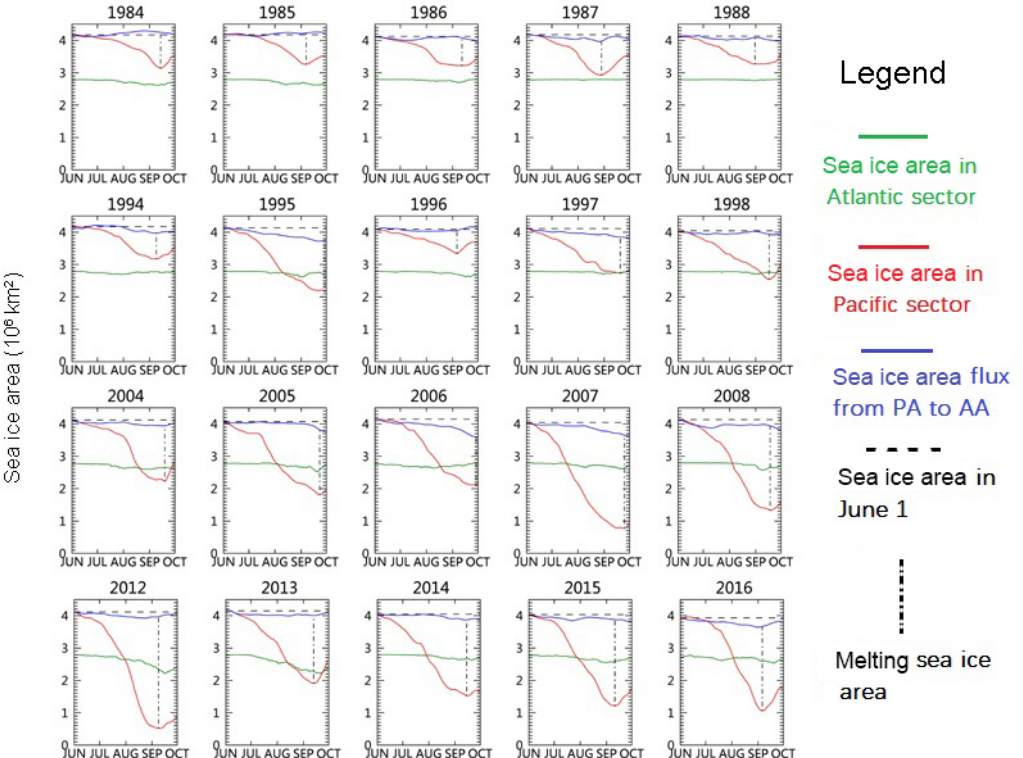
Figure 9. Selected daily changes in sea ice areas within the PA (red) and AA (green) during summer (June–September) for the period 1979– 2016. The horizontal dashed line represents the sea ice area in the PA on 1 June, which is used as a benchmark to measure the sea ice area changes due to melting. The cumulative daily sea ice area flux, with reference to the top dashed line, is shown as a blue line. The melting sea ice area, denoted by the vertical dotted–dashed line, is taken as the difference between the total decline in sea ice area within the PA and the accumulated flux through the gate.